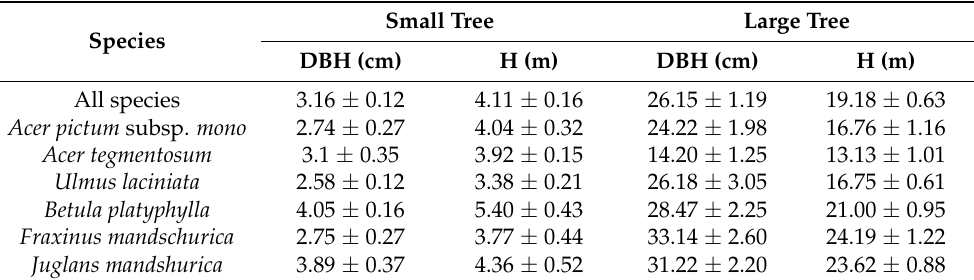
DBH: diameter at breast height of tree; H: height of